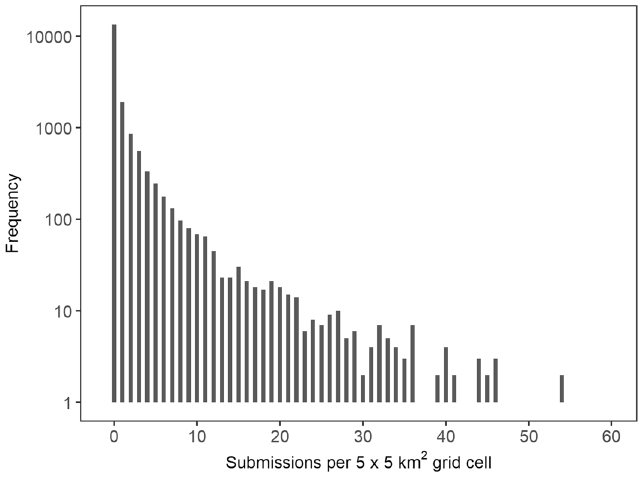
Figure 1. Histogram showing the numbers of grid cells on a log-transformed y-axis against the numbers of submissions per grid cell (limited to 60).